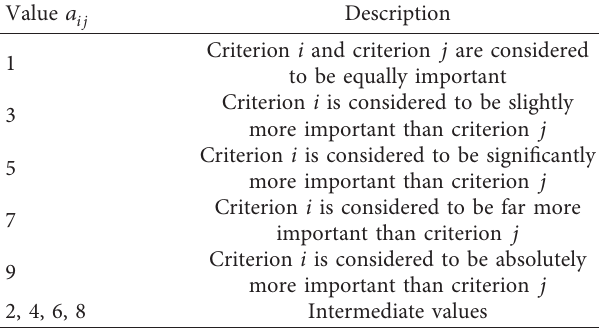
Table 2: Scale intensity of relative importance [5].